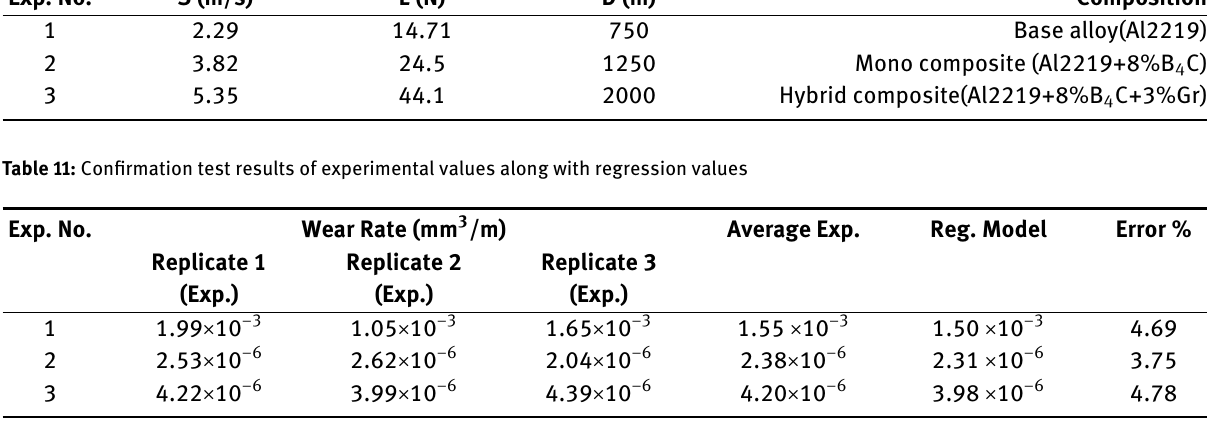
Table 10: Confirmation test parameters for wear rate of Al2219, mono and hybrid composites Exp. No.